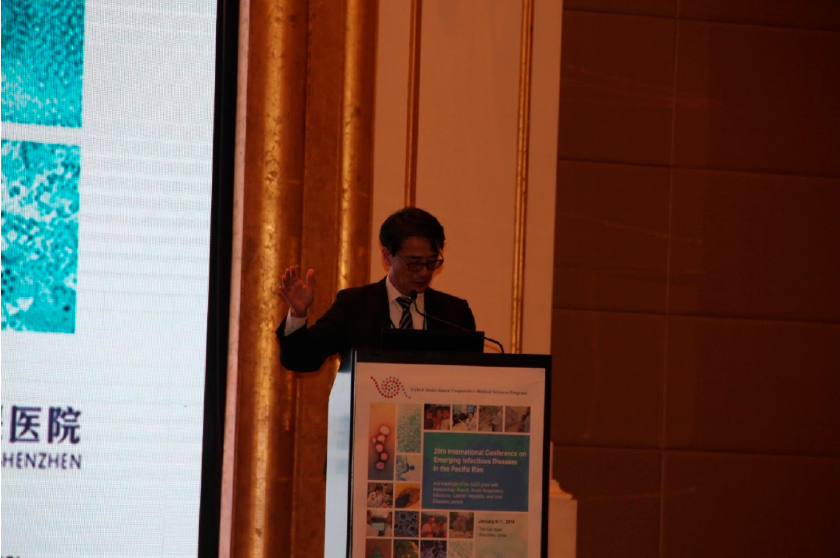
Figure 2. Dr. Takaji Wakita—Shimao-Takeda Lectureship (Photo used with permission from Dr. Wakita).